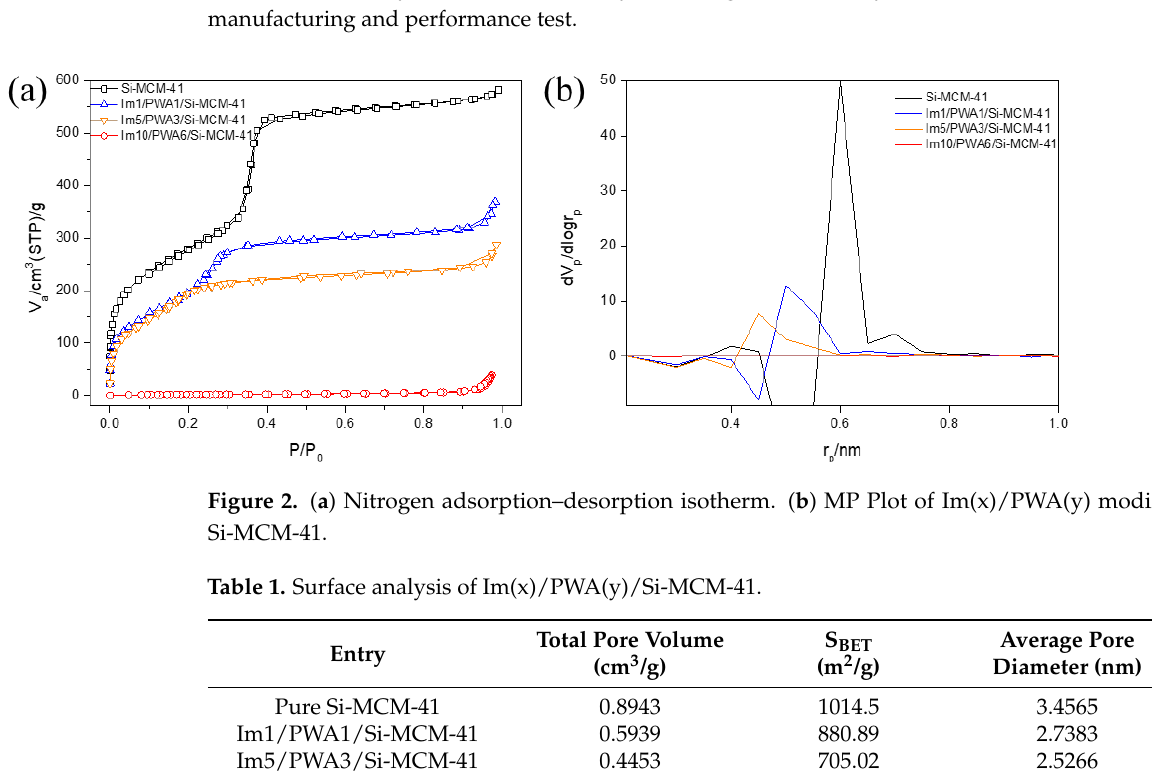
Figure 2. ( a ) Nitrogen adsorption – desorption isotherm. ( b ) MP Plot of Im(x)/PWA(y) modified Si- MCM-41.